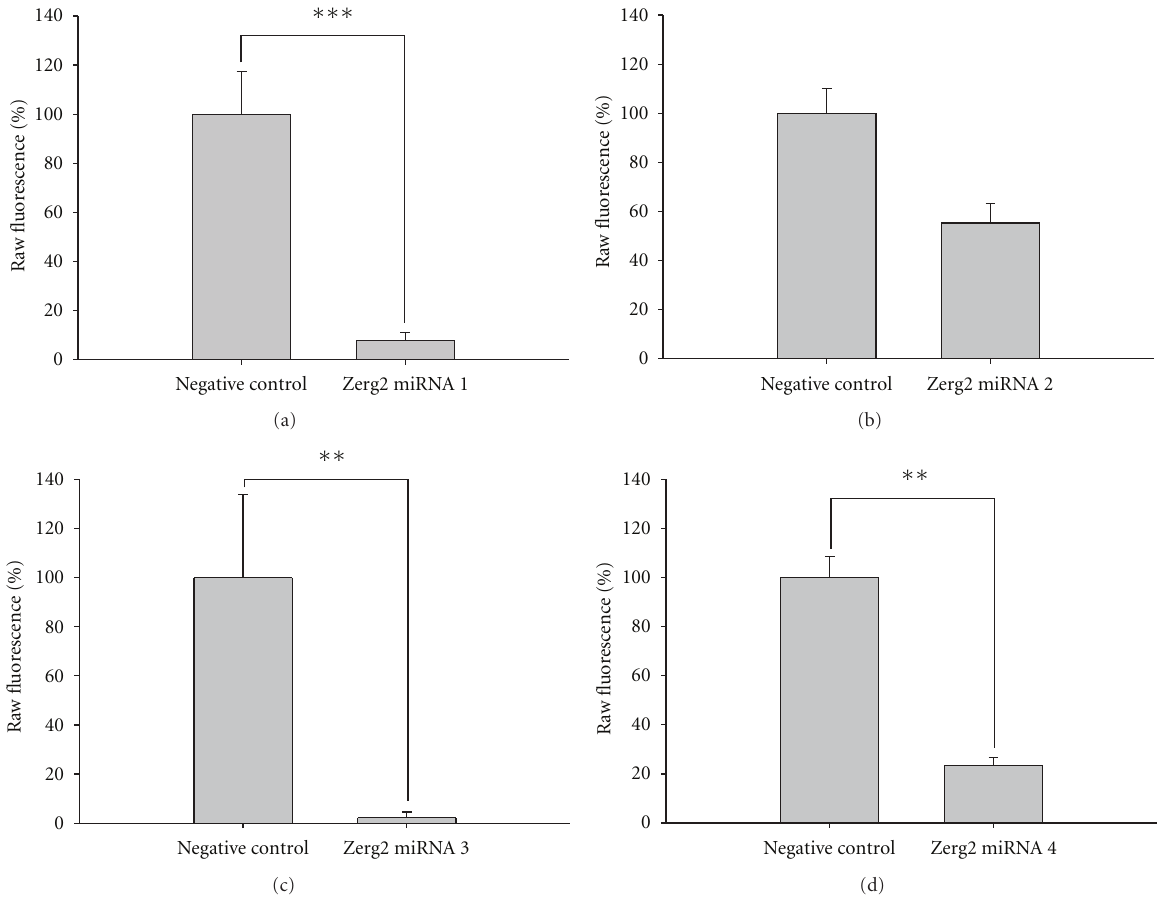
Figure 3: In vivo eGFP sensor assay for zerg-3 miRNAs. (a) zerg-3 miRNA 1 with eGFP knockdown at approximately 90%. (b) zerg-3 miRNA 2 with eGFP knockdown at approximately 45% (the results are not statically significant). (c) zerg-3 miRNA 3 with eGFP knockdown at approximately 98%. (d) zer-g3 miRNA 4 with eGFP knockdown at approximately 77%. ∗∗ P < 0 . 01; ∗∗∗ P < 0 . 001. All statistical analysis was carried out using one-way ANOVA. The percentage of fluorescence emitted by the injected embryos was determined by comparison to negative control embryos (those injected with scrambled